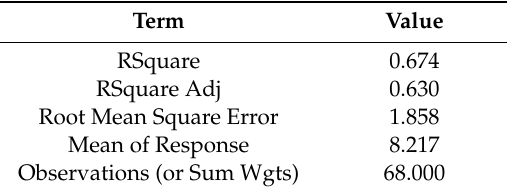
Table 7. Suitability of the model